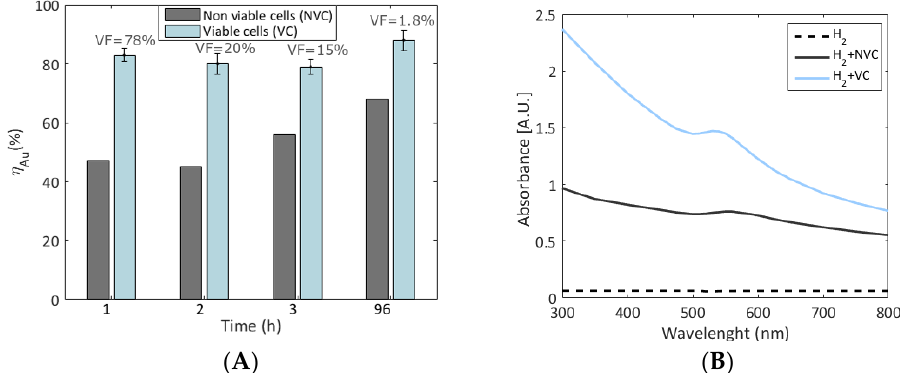
Figure 2. Comparison between heat-killed non-viable cells (NVC) and initially viable cells (VC) of S. oneidensis MR-1, following the conditions of R5 from DOE (0.2 mM of initial gold concentration, anoxic conditions, pH 5, and in the presence of H2 as an electron donor). ( A ) Gold removal efficiency ( η Au ) with time. VF values represent the percentage of remaining viable cells compared with the initial viable inoculated cells. ( B ) UV-Vis absorbance of an abiotic solution with hydrogen (H 2 ), non-filtered solutions from treatment with initially viable cells and hydrogen (H 2 +VC), and biotic controls with heat-killed cells (H 2 +NCV). Further comparison is given in the Supplementary Data.